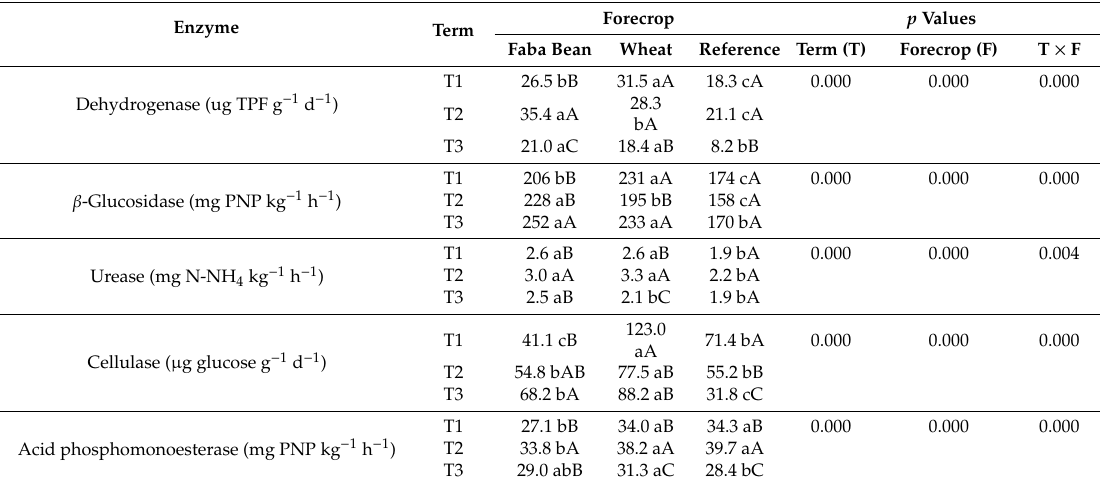
Table 5. Changes in soil activity during vegetative period as influenced by